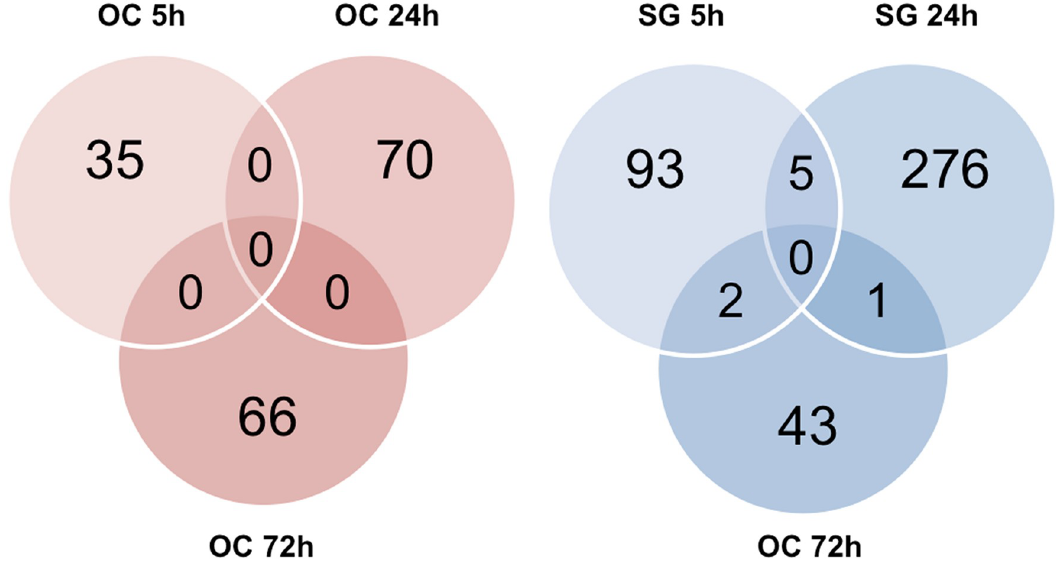
Fig 5. Venn diagrams representing the numbers of transcripts with significant changes at different time points after kainate treatment. In contrast to the organ of Corti tissues where no transcript significantly changed at more than one time points (left panel), 8 transcripts significantly changed at two different time points in the spiral ganglion tissues (right panel). OC, organ of Corti; SG, spiral